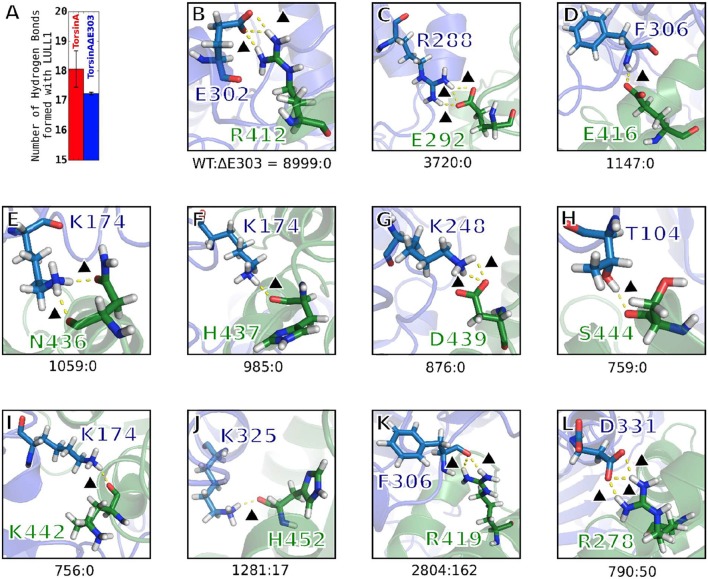
Hydrogen bonding between TorsinA and LULL1 is highly compromised by ΔE303. (A) Compared to TorsinA, TorsinAΔE303 forms fewer hydrogen bonds with LULL1. The difference is statistically significant (p < 0.001). Panels (B–L) show examples of hydrogen bonds that are frequently seen in TorsinA-LULL1 interactions but are never (or seldom) seen in TorsinAΔE303-LULL1 interactions. The hydrogen bonds were assessed in 4,500 frames out of 45,000 frames from the MD trajectories by choosing every tenth frame. Please, note that one frame may contain two or more hydrogen bonds between a given residue pairs, hence the possibility of having the overall hydrogen bonds frequency for a given residue pairs (such as 8,999 for e302-R412) greater than the number of frames. The hydrogen bonds are represented by yellow broken lines. A black triangle is placed next to each of the hydrogen bonds to guide the readers' eyes. The amino acids of TorsinA are shown in blue, while those of LULL1 are shown in green. The ratio of the frequency of a hydrogen bonding pattern in TorsinA-LULL1 interactions to its frequency in TorsinAΔE303-LULL1 interactions are presented as the numbers below each panel (e.g. TorsinA-LULL1:TorsinAΔE303-LULL1 = 8999:0 in panel B). Additional examples are provided in Supplementary Figure S2.